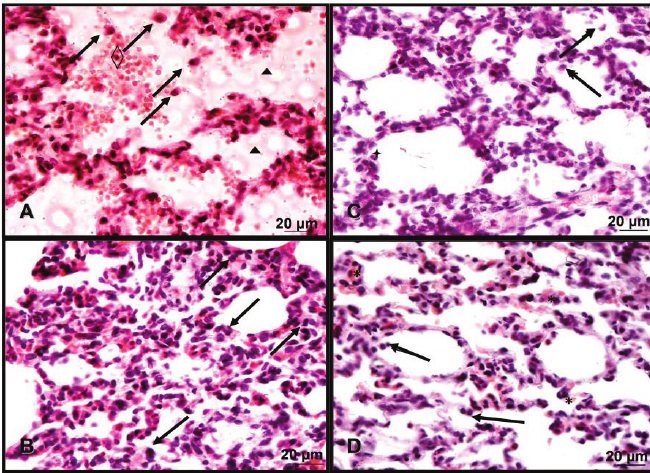
FIGURE 2 - Animals in the control group 24 hours ( A ) and control group 48 hours ( B ) show hepatocytes reactivity to caspase 3. Animals Group NAC 24 hours ( C ) and control group 48 hours ( D ) show some hepatocytes reactivity to caspase 3. (HE-400 X).